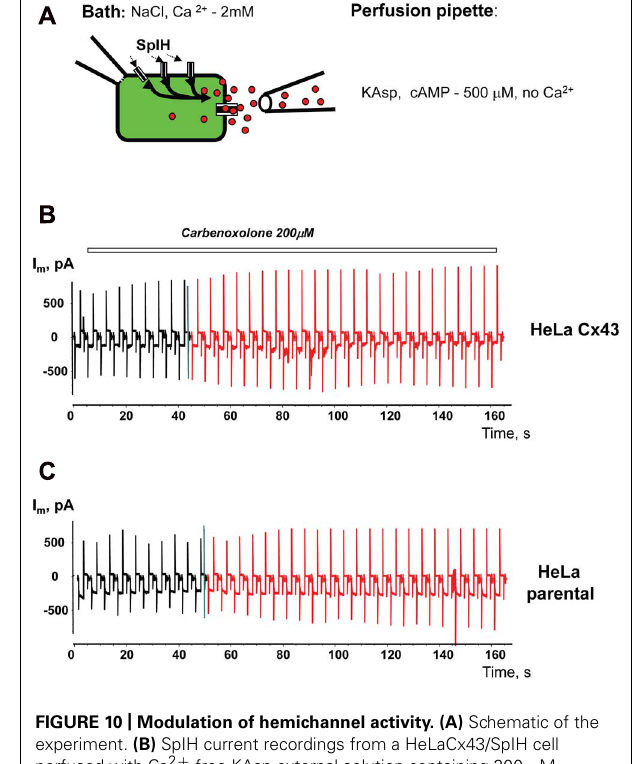
FIGURE 10 | Modulation of hemichannel activity. (A) Schematic of the experiment. (B) SpIH current recordings from a HeLaCx43/SpIH cell perfused with Ca 2 + -free KAsp external solution containing 200 μ M carbenoxolone. No SpIH current increase was detected during local application of cAMP (red current traces) in five cell preparations (6.8 ± 2.2 and 6.6 ± 2.8 pA/pF, before and during local application of cAMP, respectively; P = 1.0). (C) SpIH current recorded from connexin deficient HeLa parental cells transfected with SpIH during local application of cAMP (red current traces; 6.8 ± 1.9 and 8.7 ± 2.8 pA/pF, before and during local application of cAMP, respectively; n = 10, P =